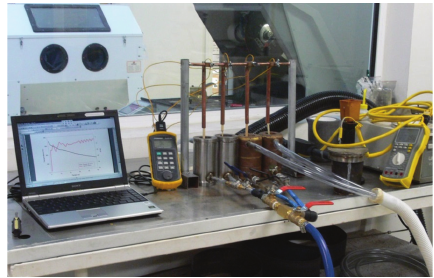
Figure 1: Experimental apparatus for thermal analysis and solidification process.